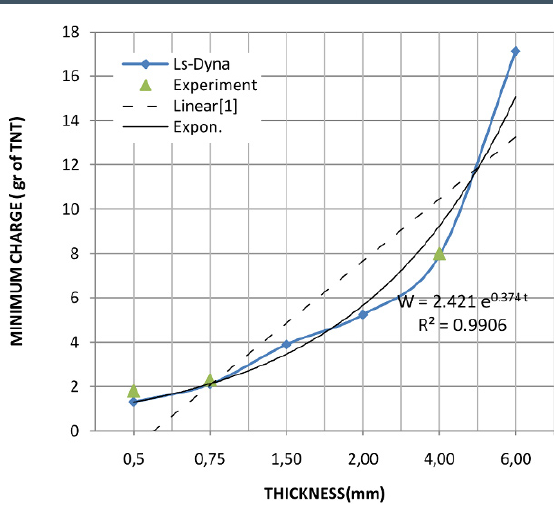
Figure 17. Linear and exponential approximations of the required charge for 300 mm